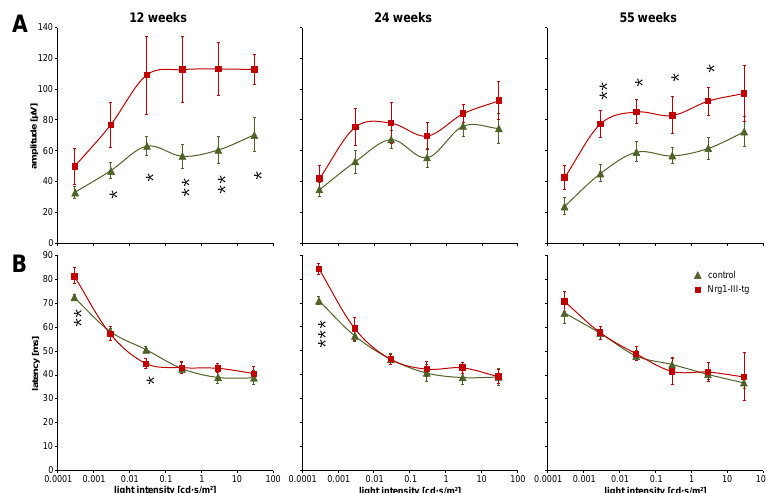
Figure 2. Scotopic VEP amplitudes and latencies in 12-, 24- and 55-week-old mice. Scotopic ampli- tudes ( A ) and latencies ( B ) of visual evoked potentials at different light intensities as indicated. Data are shown as mean values. Error bars show standard error of means. Number of animals at the age of 12, 24 and 55 weeks: n = 8, n = 13 and n = 9 control mice and n = 6, n = 5 and n = 8 Nrg1-III-tg age-matched mice, respectively. Statistical significance of differences is indicated as follows: * p < 0.05, ** p < 0.01, *** p < 0.001.